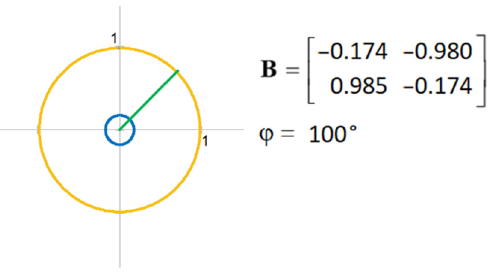
Figure 13. General tensor for rotational matrix with angle 𝜑 = 100° .